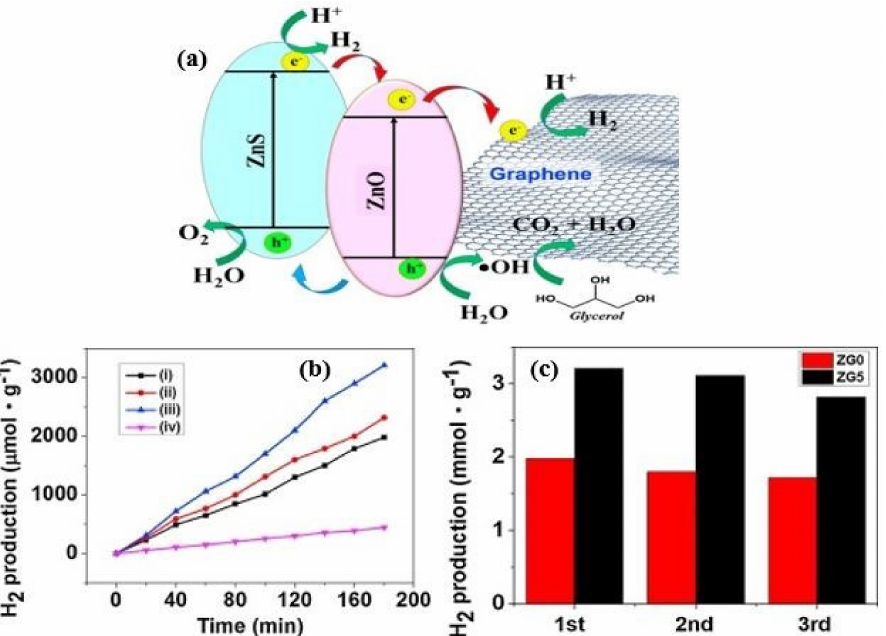
Figure 8. ( a ) Illustration of water-splitting reactions over the ZnO-ZnS/graphene photocatalyst under light irradiation. ( b ) The amount of produced H 2 by (i) ZG0, (ii) ZG1, (iii) ZG5 and (iv) ZG10 photocatalysts prepared at different graphene/ZnO-ZnS weight ratios during 3 h irradiation. ( c ) Photostability of recycled ZG0 and ZG5 photocatalysts with 3 h of irradiation for each test. (Reprinted with permission from reference [123]. Copyright 2018,